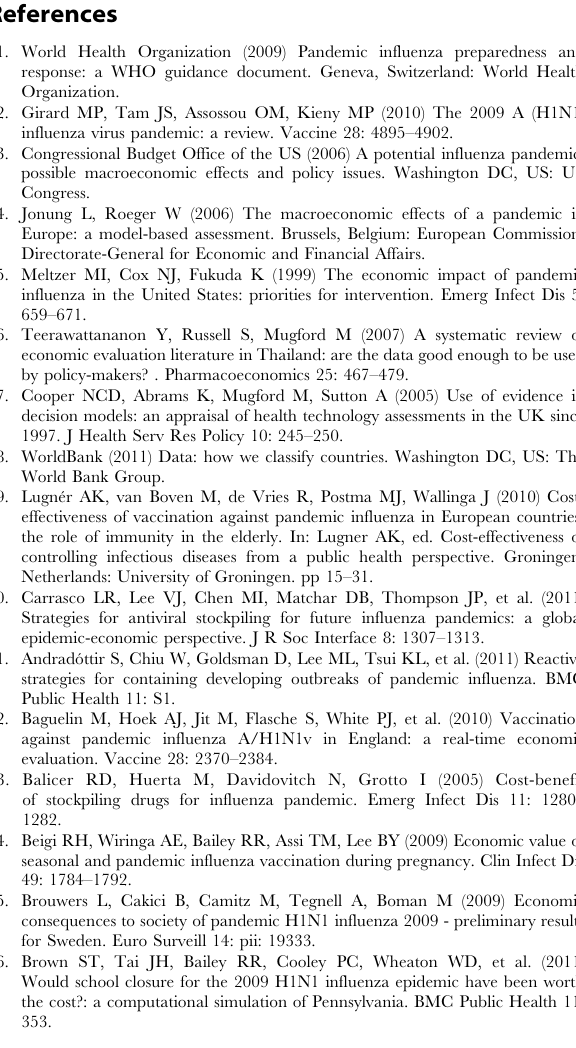
Table S6 Types of parameters affecting the incremental cost effectiveness ratios*. Table S7 Description of contact patterns across dynam- ic models included in the review. Table S8 Number of interventions by type of interven-